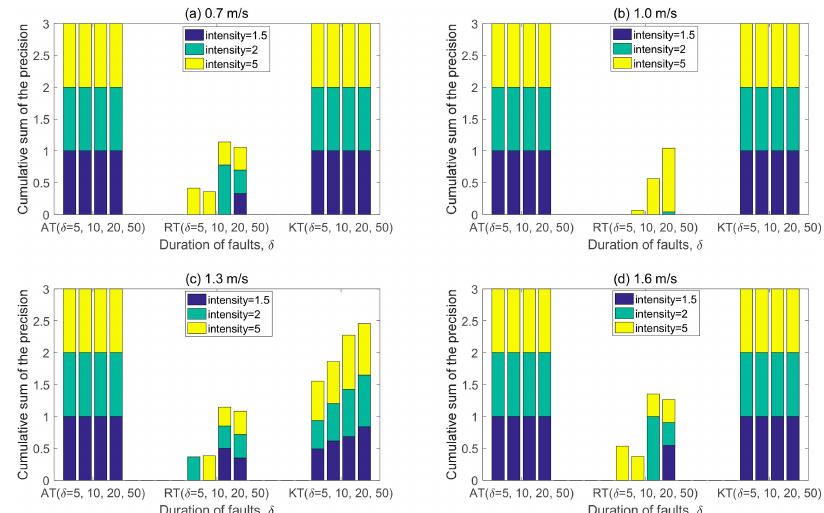
Figure 6. Precision according to each intensity as a function of constant fault duration: ( a ) Cumulative sum of the precision at 0.7 m/s of Jackal UGV; ( b ) Cumulative sum of the precision at 1.0 m/s; ( c ) Cumulative sum of the precision at 1.3 m/s; ( d ) Cumulative sum of the precision at 1.6